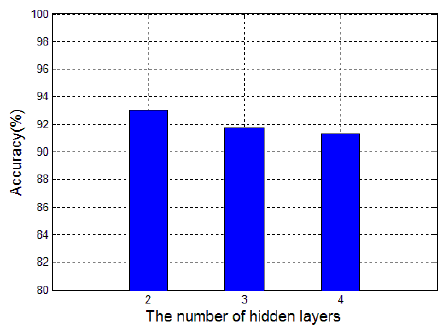
Figure 8. Influence of the number of hidden layers on classification accuracy.